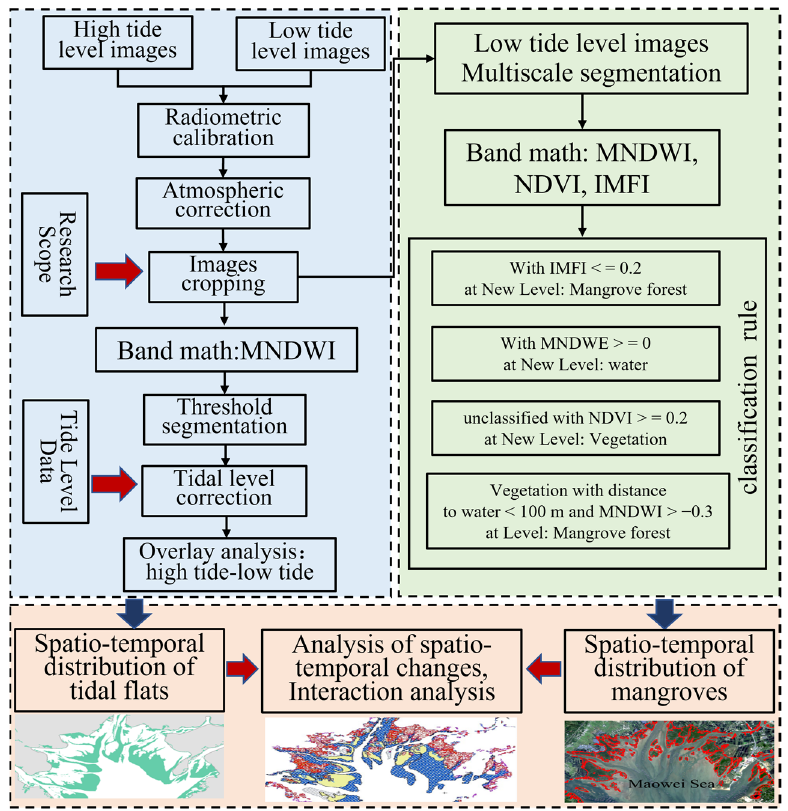
Figure 8. Research technical route of this study.